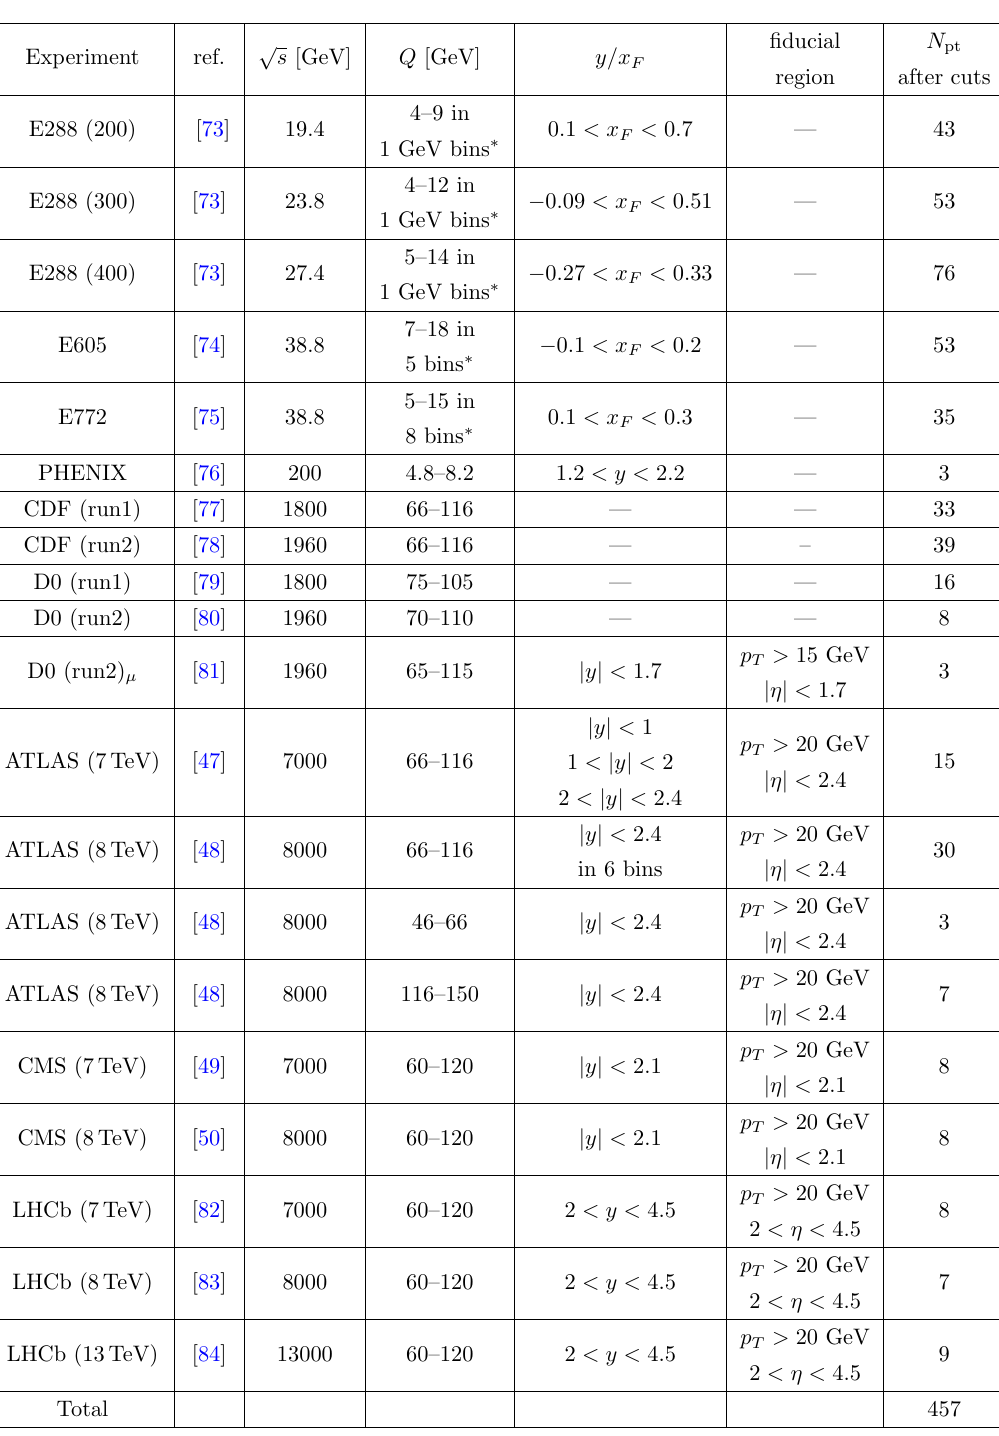
Table 3 . Summary table for the data included in the (cid:12)t.. For each data set we report: the reference publication, the centre-of-mass energy, the coverage in Q and y or x F , possible cuts on the (cid:12)ducial region, and the number of data points that survive the cut in eq. (3.3).